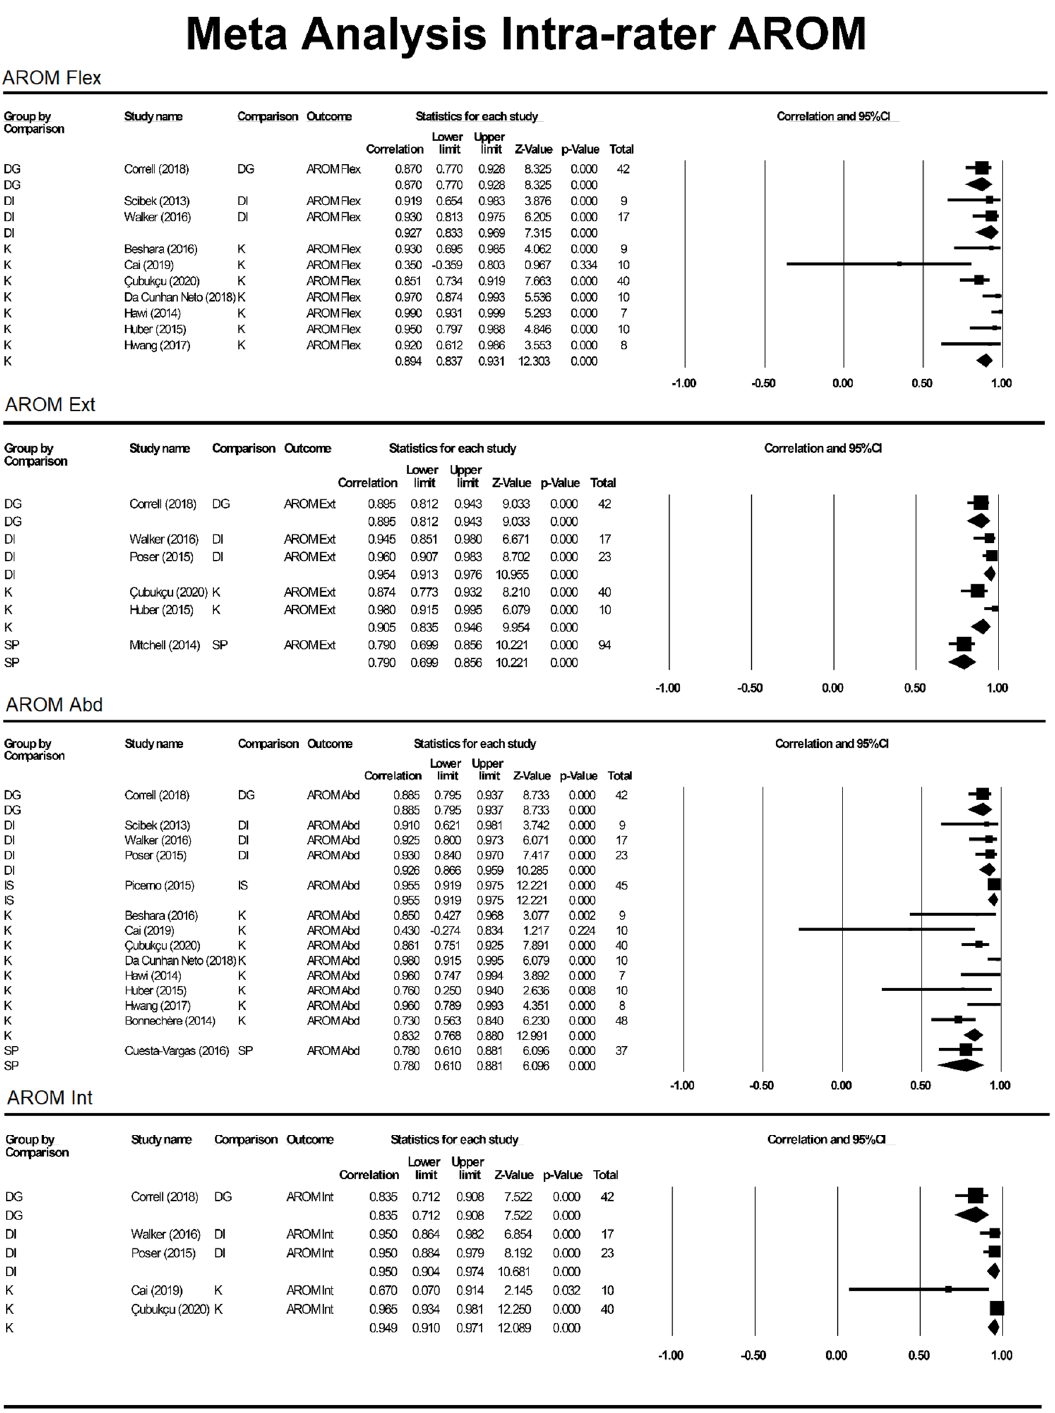
Figure 2. Meta-analysis for intra-rater AROM. DG = digital goniometer, DI = digital inclinometer, IS = inertial sensor, K = Kinect, SP = smartphone, Abd = abduction, AROM = active range of motion, Int = internal rotation, Ext = external